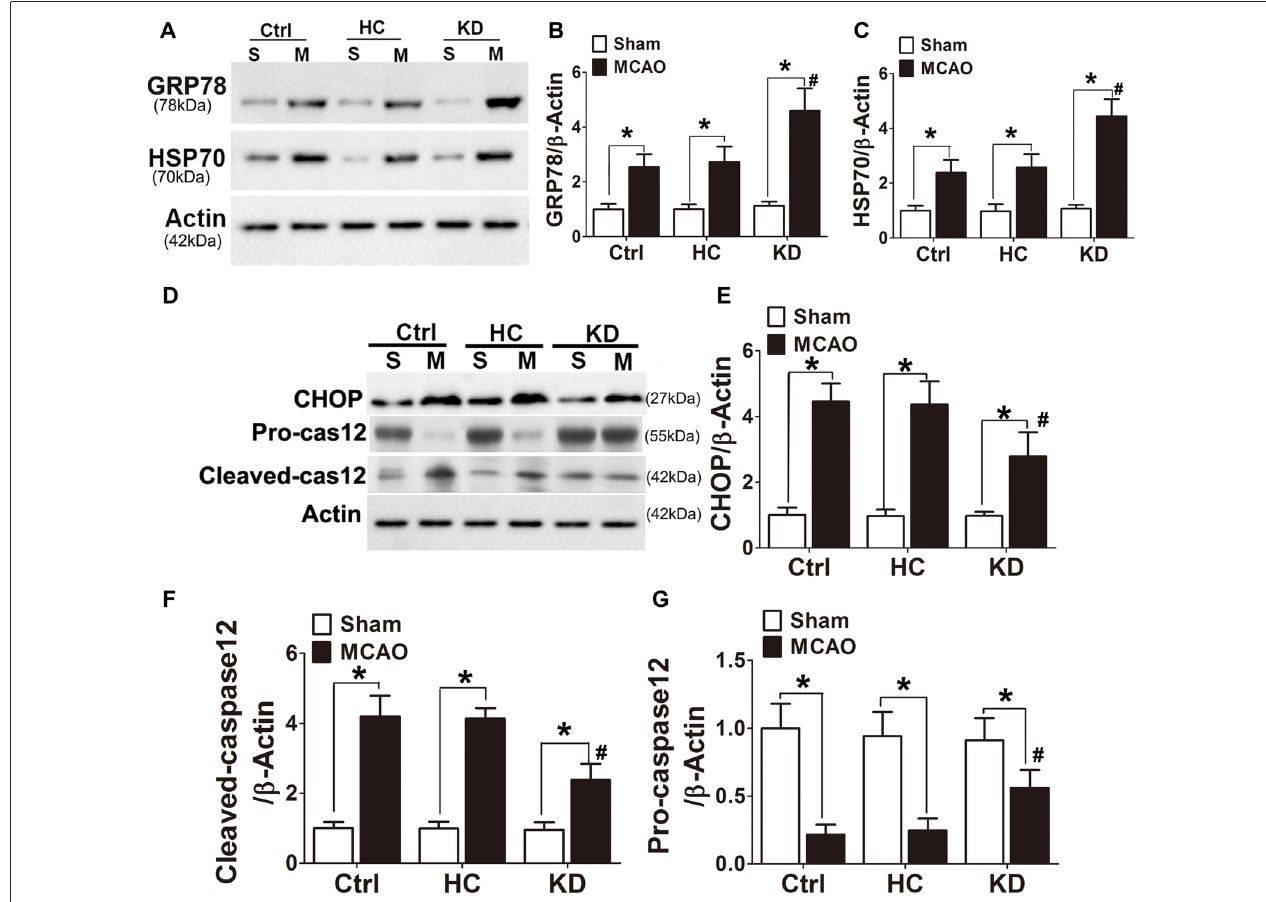
FIGURE 8 | KD increased GRP78/HSP70 level but attenuated CHOP and cleaved caspase 12 expression in MCAO mice. Sham-operated and MCAO mice ( n = 6 in each group) were fed with different diet protocols and Western blotting (A,D) was performed to determine the protein expression of GRP78 (B) , HSP70 (C) , CHOP (E) , cleaved-caspase 12 (F) and pro-caspase 12 (G) . Representative blots from six independent experiments with similar results are shown. Data are shown as mean ± SEM; ∗ P < 0.01 vs. sham-operated mice, # P < 0.05 vs. MCAO